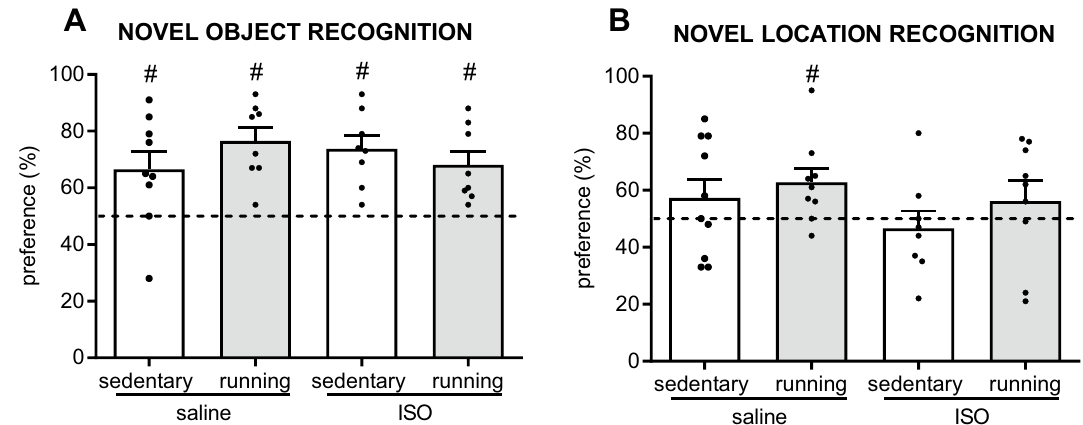
Figure 5. Short-term memory tested as recognizing a novel object (NOR) or a novel location (NLR) in saline or isoproterenol (ISO) treated rats, under sedentary conditions or after five weeks of exercise training, (NOR: n = 9, 9, 8, 8 for saline sedentary, saline exercise, ISO sedentary and ISO exercise rats, respectively; NLR: n = 10, 9, 8, 9 for saline sedentary, saline exercise, ISO sedentary and ISO exercise rats, respectively). #: significantly different from random performance (= 50%; dashed line).